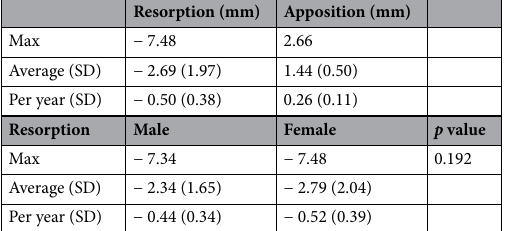
Table 1. Quantitative assessment of condylar surface changes using point-to-point distances on the registered condylar models between T 0 and T 2 . Values are expressed as mean (standard deviation). SD standard deviation.